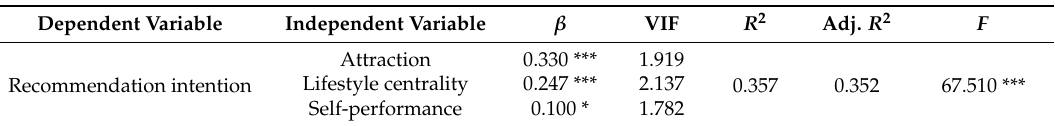
Table 5. Multiple regression analysis between subdimensions of involvement and recommendation intention.